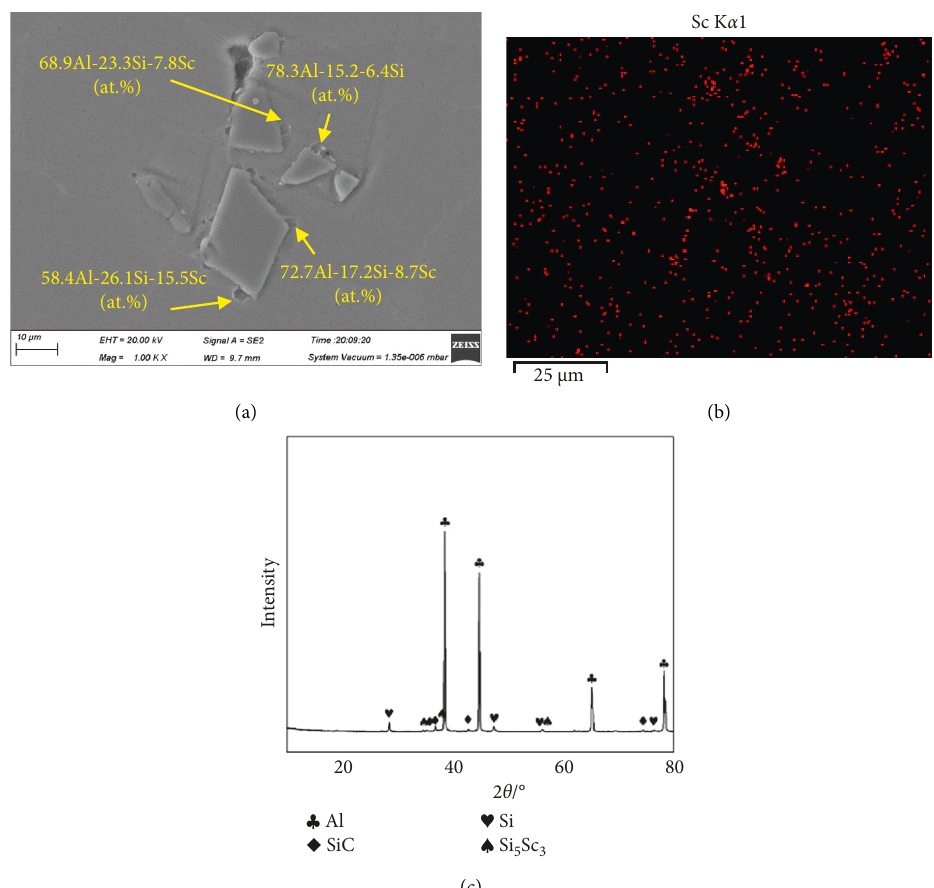
Figure 11: SEM image and EDS result of SiCp/A356 composites after adding Sc. (a) SEM image, (b) EDS map of Sc, and (c) XRD